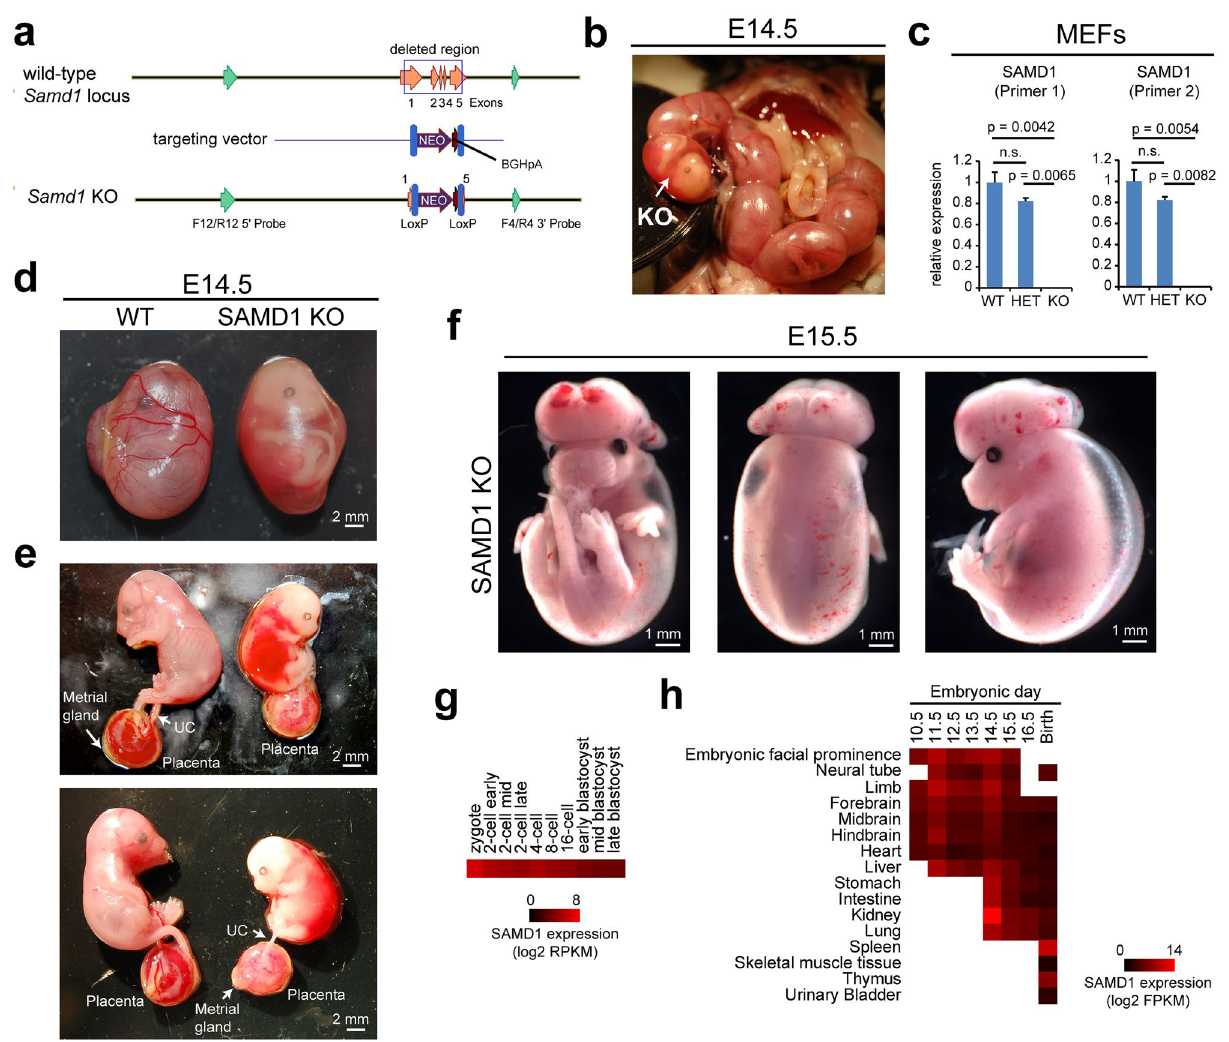
Figure 1. SAMD1 KO mice are embryonic lethal and lack intact blood vessels. ( a ) Gene targeting strategy to obtain SAMD1 KO mice. Southern probes are marked in green. ( b ) A SAMD1 KO embryo is easily distinguished from the WT embryos as soon as the litter is partially removed from the uterus. ( c ) RT-qPCR of SAMD1 in mouse embryonic fibroblasts (MEFs) obtained from wild-type and SAMD1 homo- and heterozygous embryos. Data are presented as the mean ± SD of two biological replicates. P-values via two-way ANOVA with Tukey’s multiple comparisons test. n.s. = not significant. ( d ) Pictures of embryos at E14.5 within the yolk sac. ( e ) Pictures of embryos at E14.5, without yolk sac, but still within the amnion. The placenta is shown underneath. ( f ) Picture of a SAMD1 KO mouse at approx. E15.5. ( g ) Gene expression of SAMD1 during early embryogenesis 23 . ( h ) SAMD1 gene expression in various embryonic tissues based on data from ENCODE 24